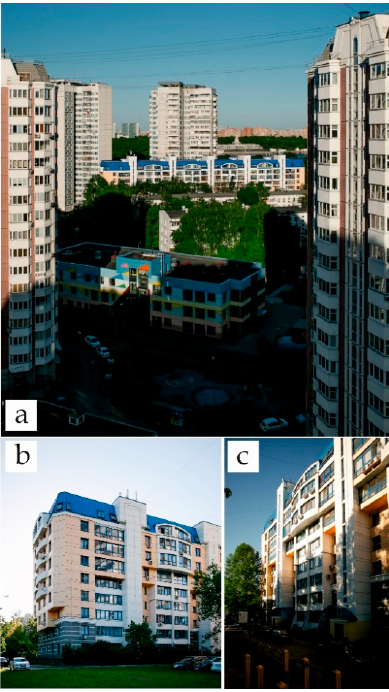
Figure 11. Reconstruction of a house with the superstructure of floors according to project A. Krotov: ( a ) The house after reconstruction in the neighborhood environment. ( b , c ) The house is given an individual appearance by the architectural and planning techniques proposed by the author, reviving the residential environment. (https://www.akrotov.ru (accessed on 15 January